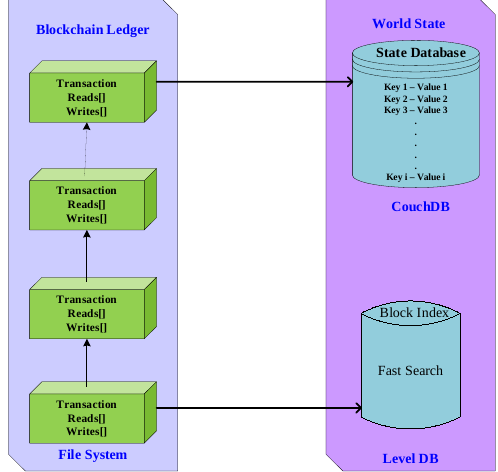
Figure 1. The Ledger in HLF